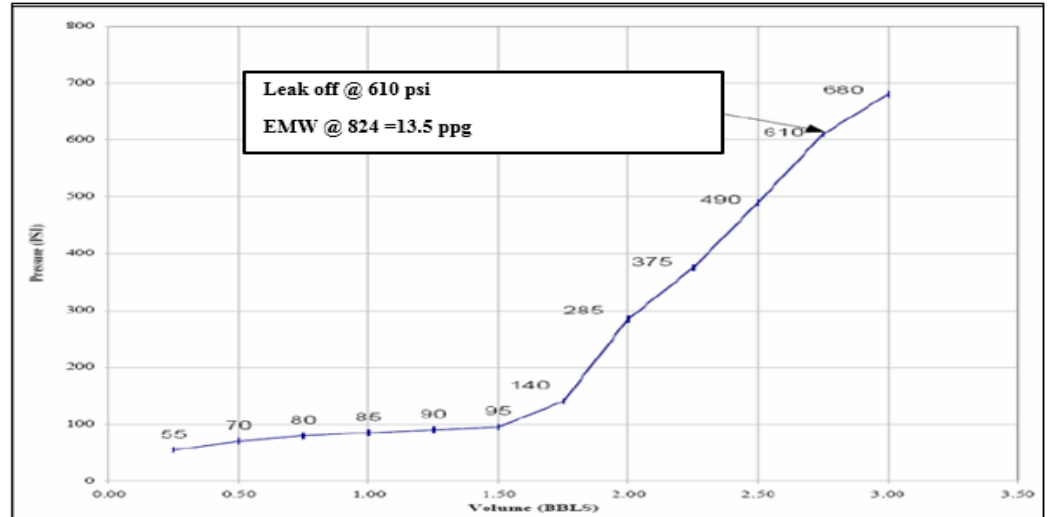
Figure 23. Leak off test at 824 m true vertical depth (TVD) for Well N-8.